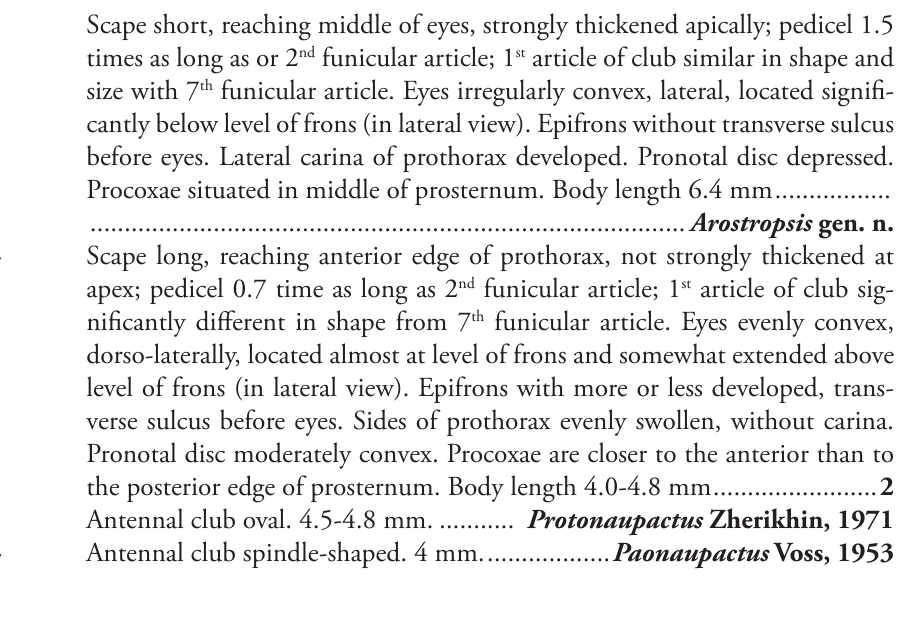
Key to Baltic amber genera of Entiminae with free claws Scape short, reaching middle of eyes, strongly thickened apically; pedicel 1.5 times as long as or 2 nd funicular article; 1 st article of club similar in shape and size with 7 th funicular article. Eyes irregularly convex, lateral, located signifi- cantly below level of frons (in lateral view). Epifrons without transverse sulcus before eyes. Lateral carina of prothorax developed. Pronotal disc depressed.